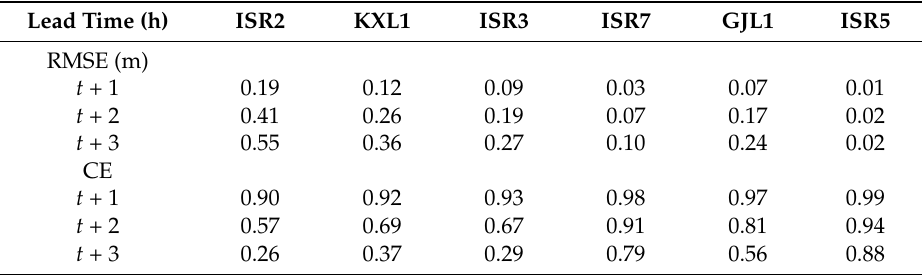
Table 4. RMSE and CE values for the point forecasting module for 1–3 h lead time forecasting.